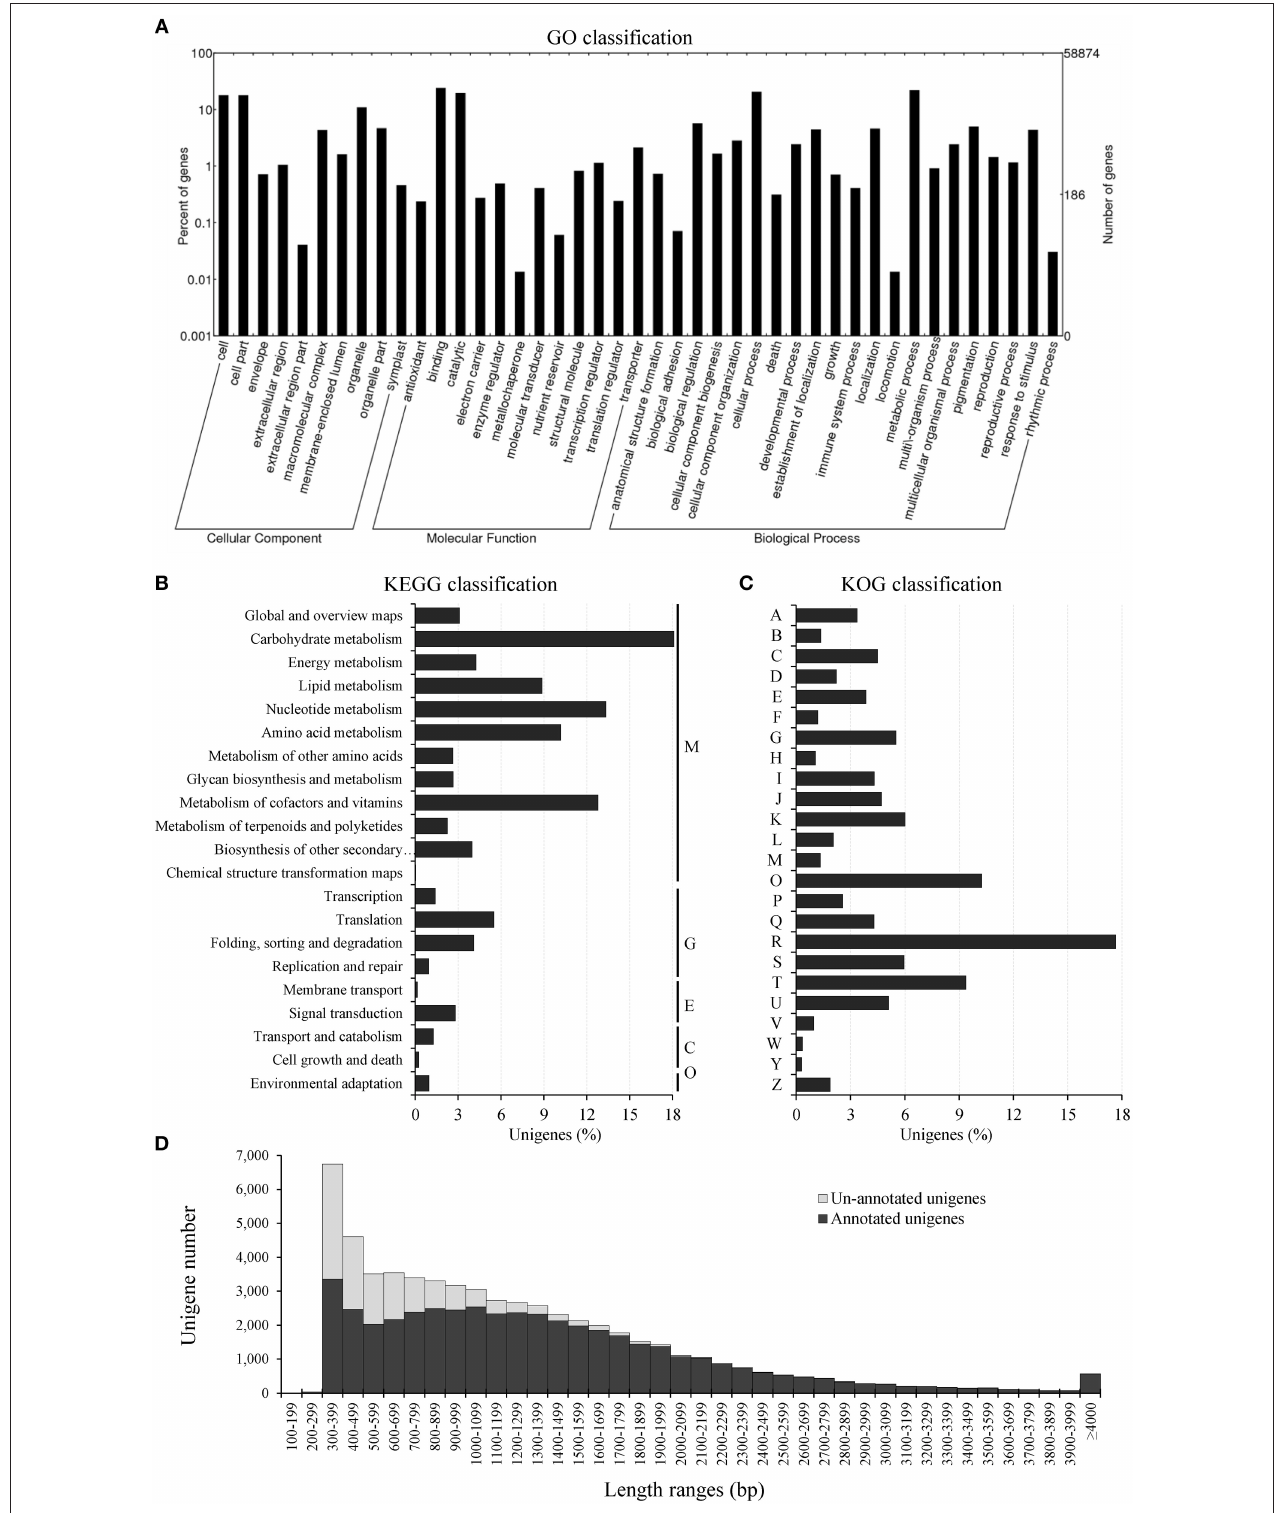
FIGURE 2 | Annotation of Chicorium intybus unigenes. (A) GO classification. The GO terms were classified into three ontologies: biological process, cellular component, and molecular function. (B) KEGG classification. The histogram represents the unigene distribution into five major KEGG metabolic categories. M, metabolism; G, genetic information processing; E, environmental information processing; C, cellular processes; O, organismal systems. (C) Unigene functional